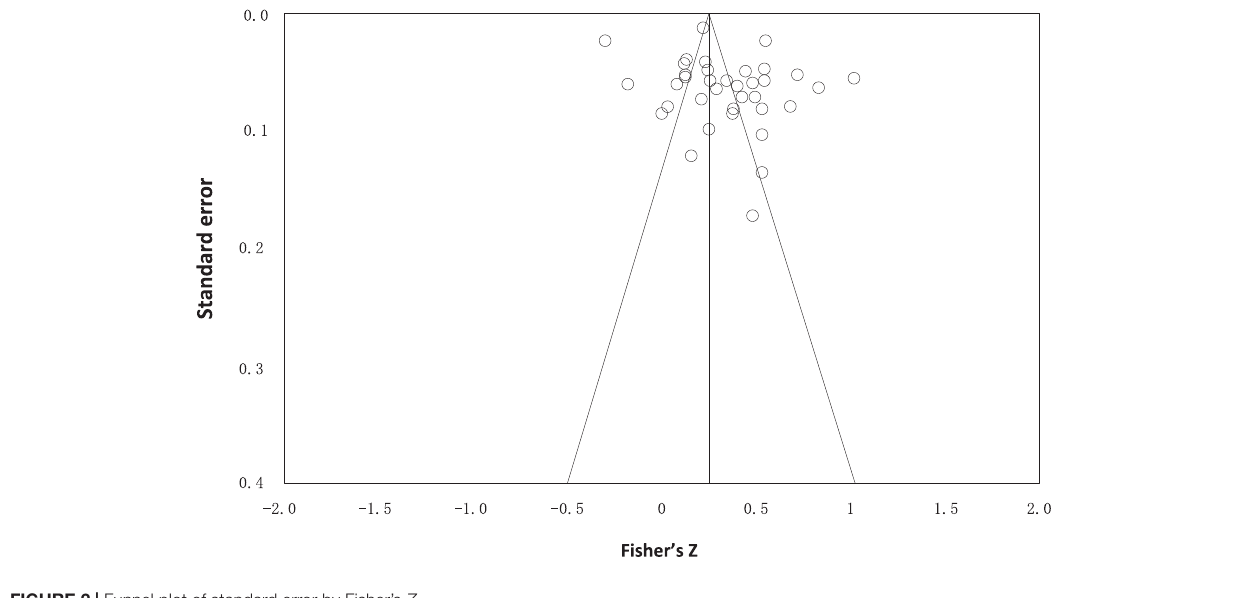
FIGURE 2 | Funnel plot of standard error by Fisher’s Z .